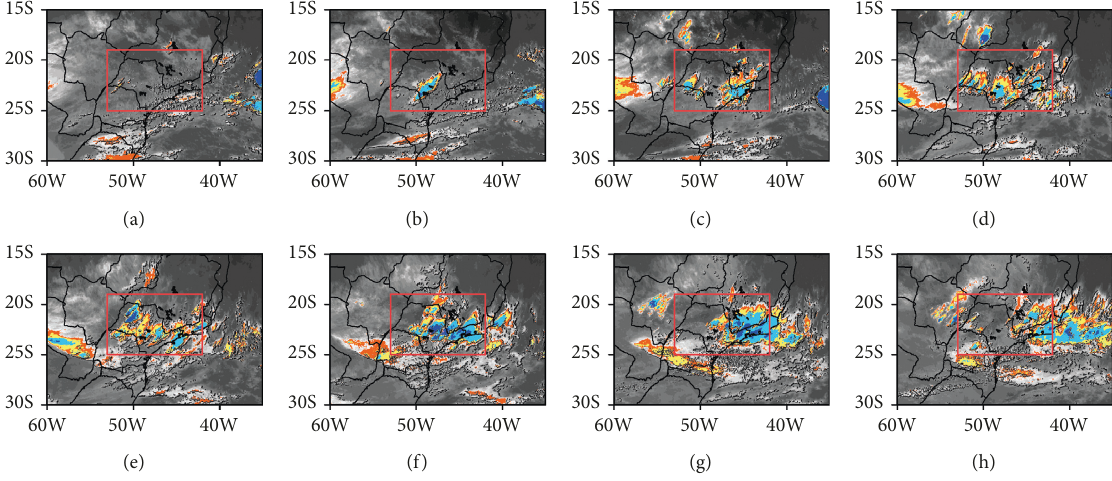
Figure 2: GOES-13 enhanced infrared images on June 04, 2016, at (a) 1200 UTC, (b) 1500 UTC, (c) 1800 UTC, and (d) 2100 UTC; and on June 05, 2016, at (e) 0000 UTC, (f) 0300 UTC, (g) 0600 UTC, and (h) 0900